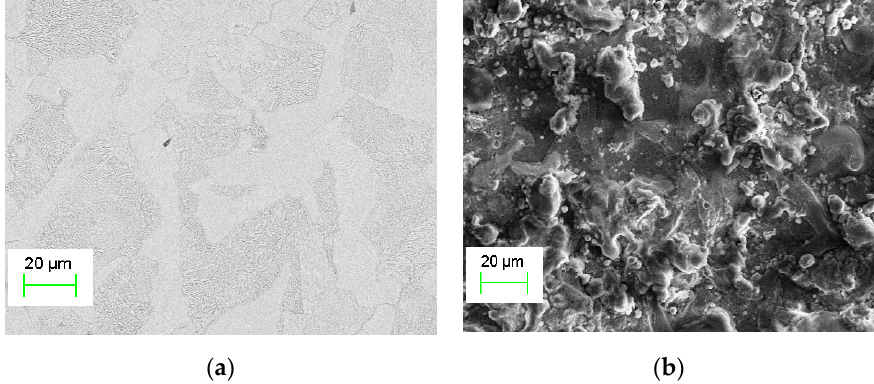
Figure 10. SEM micrographs of the surface of the samples: ( a ) no corrosion; ( b ) 8 h of corrosion.